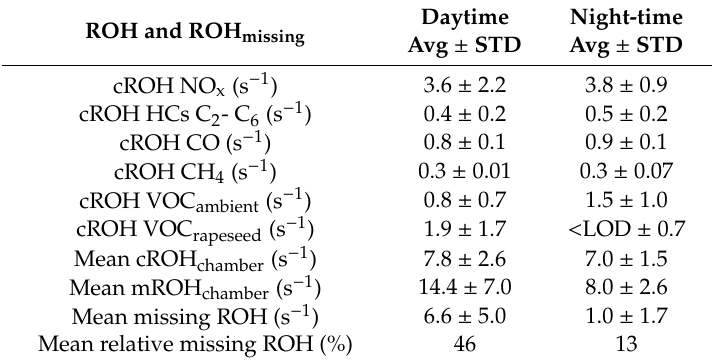
Table 3. Summary of the mean contribution of all the measured species (same time step) in the incoming and the outgoing chamber air to mROH chamber and the resulting missing OH fraction.